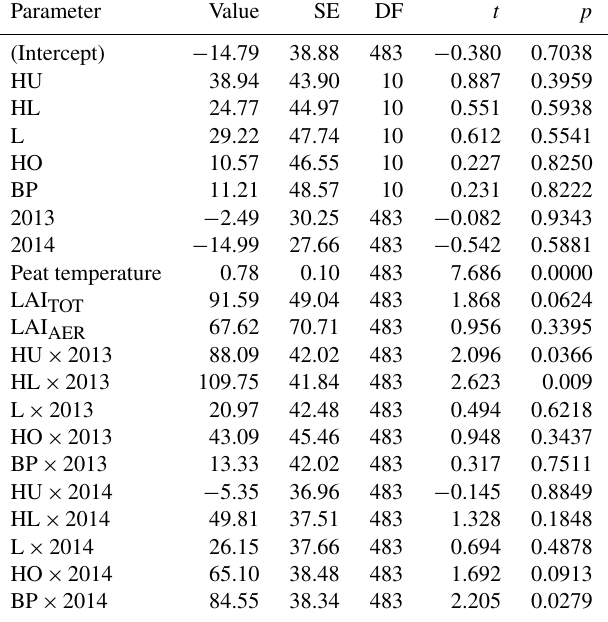
Table A1. Parameter estimates of the linear mixed-effects model for methane flux. Estimate value, standard error (SE), degrees of freedom (DF), and test statistics t and p values are given to the fixed predictors of the model as compared to high hummocks in 2012 (intercept). Fixed predictors are plant community type divided into high hummocks, hummocks (HU), high lawns (HL), lawns (L), hollows (HO) and bare peat surfaces (BP), measurement year (2012–2014), interaction of plant community type and year (e.g., HU × 2013), peat temperature at the depth of 5cm, leaf area index of all vegetation (LAI TOT ) , and leaf area index of aerenchymatous plant species (LAI AER )